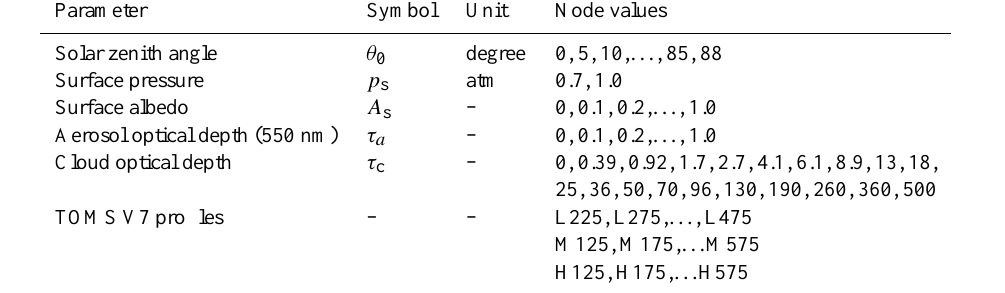
Table 3. Node points of the look-up table for the dose rates and photolysis frequencies. The full 26 profile set of the TOMS V7 climatology is used. L, M and H refer to the low, middle and high latitude profiles, respectively, while the numbers refer to total ozone columns in DU. Parameter